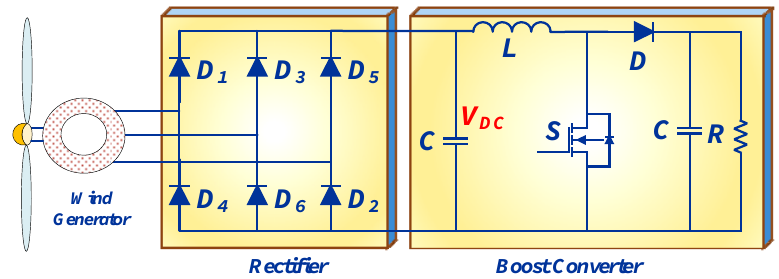
Figure 1. Basic configuration of wind energy conversion system (WECS).